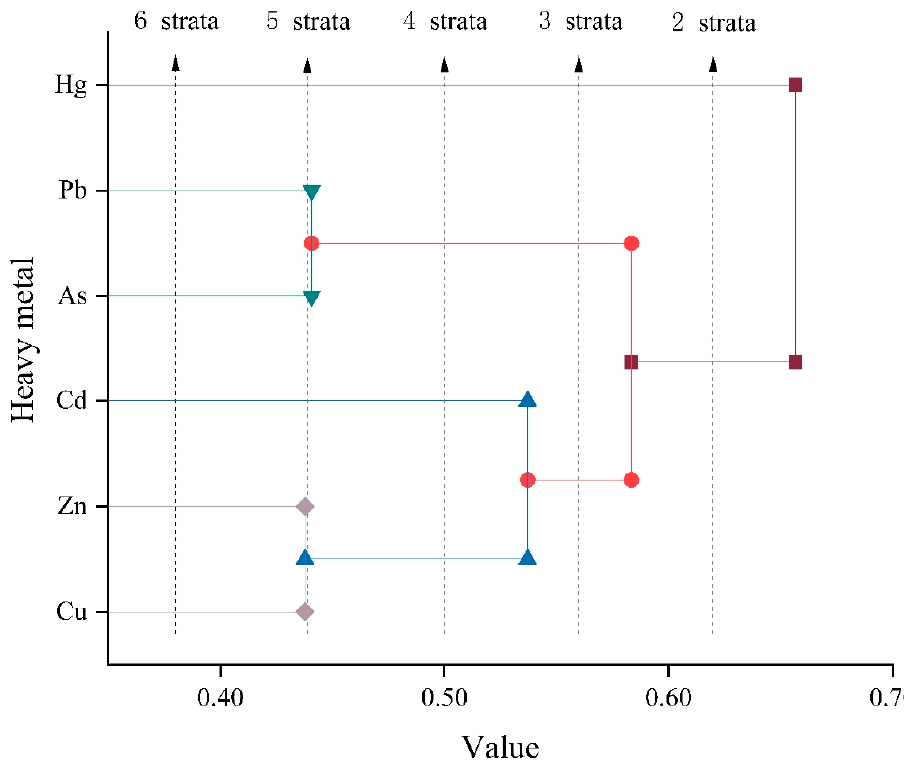
Figure 6. Fuzzy clustering results for six heavy metals in the Shunyi District. Table 5. The correlation analysis results of heavy metal concentrations and influencing factors.